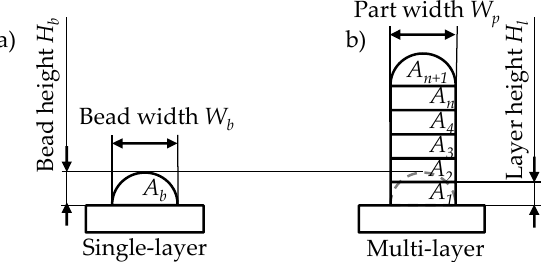
Figure 2. Schematic cross-sectional geometry of ( a ) a single-layer (bead) and ( b ) a multi-layer part. The idealized width of the part wall W p was assumed to be equal to W b . Due to the volume constancy A b = A n , with A n being the cross-sectional area of a single layer within the part wall, the height of each layer H l within the part had to differ from H b due to the geometry. To calculate H l , a formula was derived by using the following equations: The volume of a bead V b can be calculated using the length of the bead l and the cross-